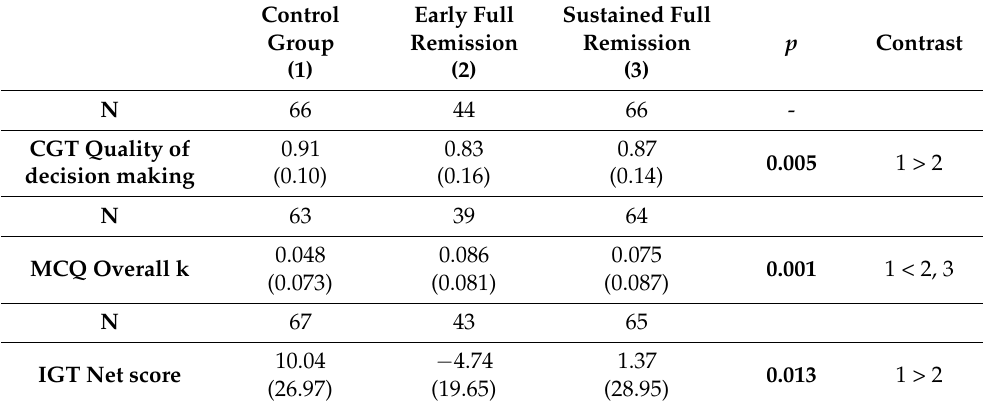
Table 2. Descriptive statistics and group differences on indices of impulsive choice.